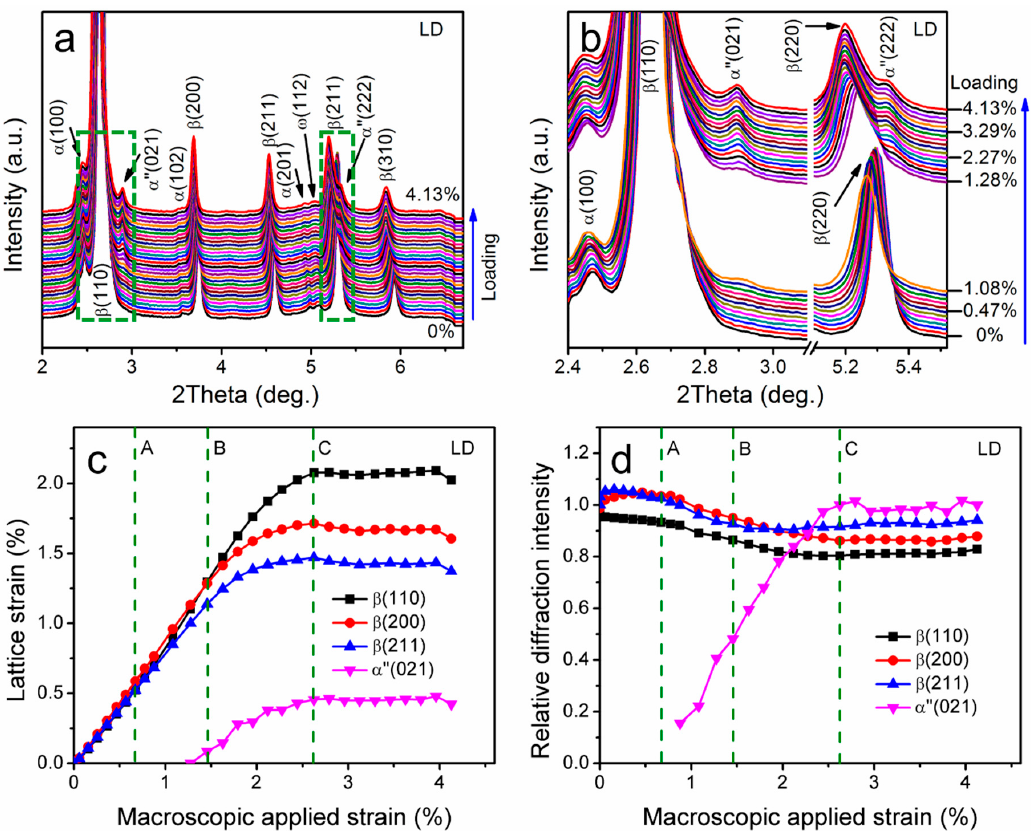
Figure 4. In situ SXRD analysis of the microstructural characteristics of the Ti36Nb5Zr alloy along LD. ( a ) One-dimensional SXRD spectrums. ( b ) Enlarged views of the boxed areas in ( a ). Evolution of the ( c ) lattice strains and ( d ) relative integrated diffraction peak intensities of the (110) β , (200) β , (211) β and (021) α ” crystal planes as functions of the macroscopic applied strain. A, B and C in ( c ) and ( d ) represent the different macroscopic strains noted in Figure 3b.